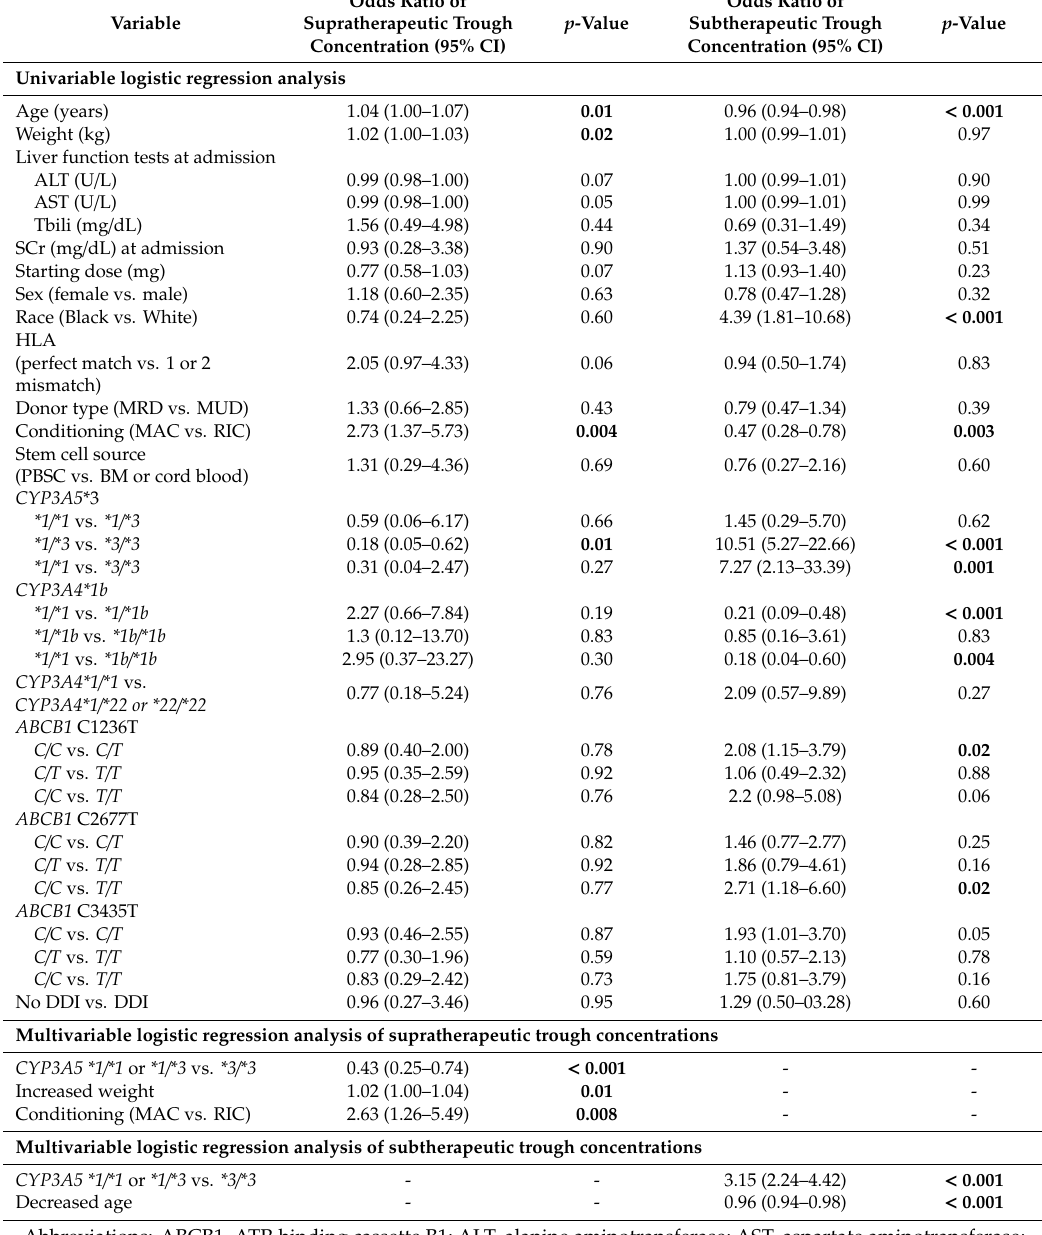
Table 4. Analyses of supratherapeutic and subtherapeutic steady-state tacrolimus trough concentrations. Univariate logistic regression analyses evaluated supratherapeutic ( > 15 ng / mL) and subtherapeutic ( < 5 ng / mL) steady-state tacrolimus trough concentrations for clinical and demographic characteristics, as well as CYP3A4 / 5 and ABCB1 SNPs. Factors that significantly associated with supratherapeutic steady-state tacrolimus trough concentrations ( p < 0.05) were evaluated as potential covariates in multivariable analyses. Factors that associated with significantly increased odds of supratherapeutic or subtherapeutic steady-state tacrolimus trough concentrations ( p < 0.05) are bolded